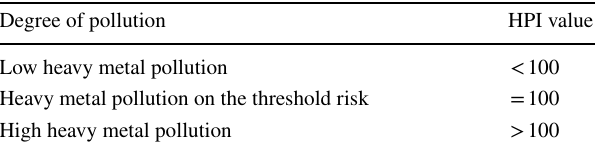
Table 1 Evaluation of heavy metal pollution, HPI value (Sobhanarda- kania et al.